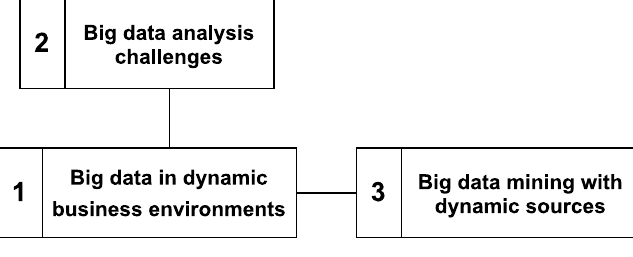
Figure 2. Concept map of the conducted